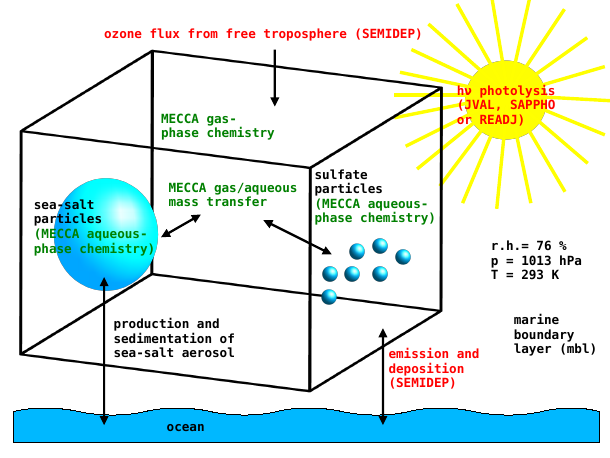
Fig. 2. Illustration of the CAABA box model. MECCA chemistry is shown in green, and processes calculated by other submodels in